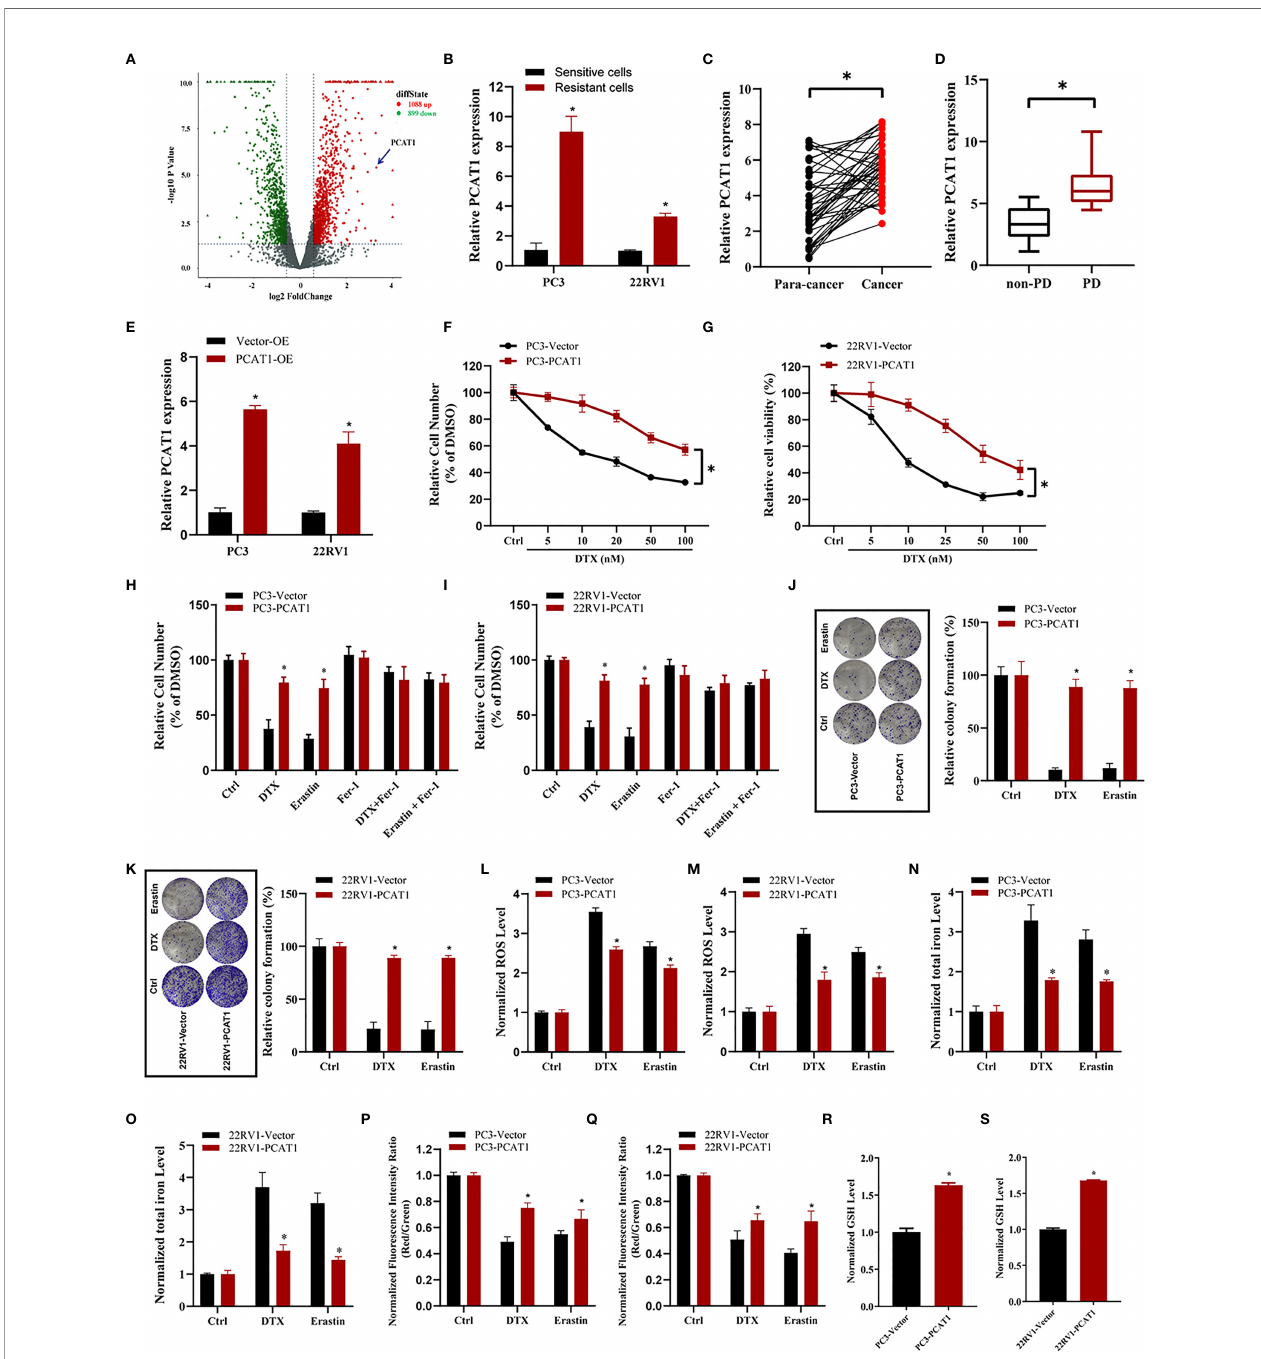
FIGURE 2 | PCAT1 overexpression increases DTX resistance and inhibits ferroptosis. (A) Volcano plot representative the differentially expressed lncRNAs in DTX- resistant PC3/DR cells and counterpart PC3 cells. The red and green represent the upregulated and downregulated lncRNAs. (B) The expression of PCAT1 was assessed by qRT-PCR in DTX-resistant PCa cells (PC3/DR and 22RV1/DR) and their sensitive cells (PC3 and 22RV1). (C) The relative expression of PCAT1 was evaluated by qRT-PCR in 42 pairs of PCa tissues and para-cancer samples. (D) qRT-PCR analysis of PCAT1 in the pre-therapy plasma of PCa patients with progressive disease (PD) (n=15) or non-PD (n=18) after DTX chemotherapy. (E) The ef fi ciency of PCAT1 overexpression in PC3 and 22RV1 cells was detected by qRT-PCR. (F, G) The cell viability was evaluated in PC3 and 22RV1 cells after transfected with PCAT1 upon different dosage of DTX treatment for 72 hours. (H, I) CCK-8 assay was used to analyze the response of PCAT1-induced PC3 and 22RV1 cells to DTX, erastin and ferrostatin-1. (J, K) Colony formation assay was used to assess cell survival in PCAT1-overexpressed PC3 and 22RV1 cells after DTX or erastin treatment. (L, M) Lipid ROS content, (N, O) total iron concentration, (P, Q) the mitochondrial membrane potential were evaluated in PC3 and 22RV1 cells after PCAT1 overexpression upon DTX and erastin treatment. (R, S) The GSH content was assessed in PCAT1-induced PC3 and 22RV1 cells. The data are presented as the means ± S.D. of at least three independent experiments. * P